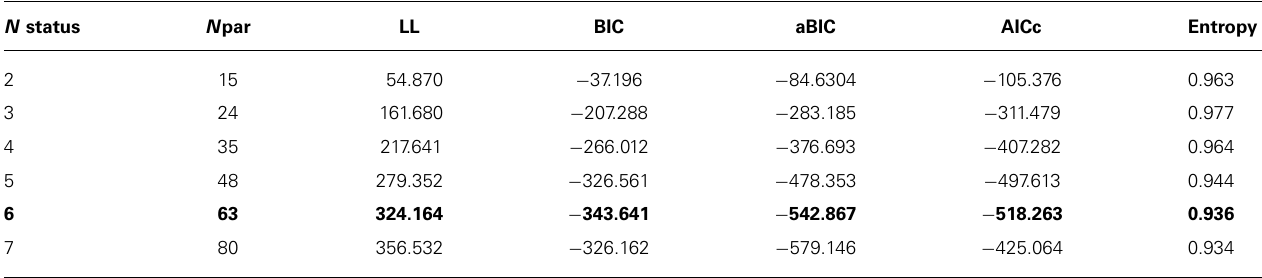
Table 3 | Model fit information used in selecting the latent transition analysis model.